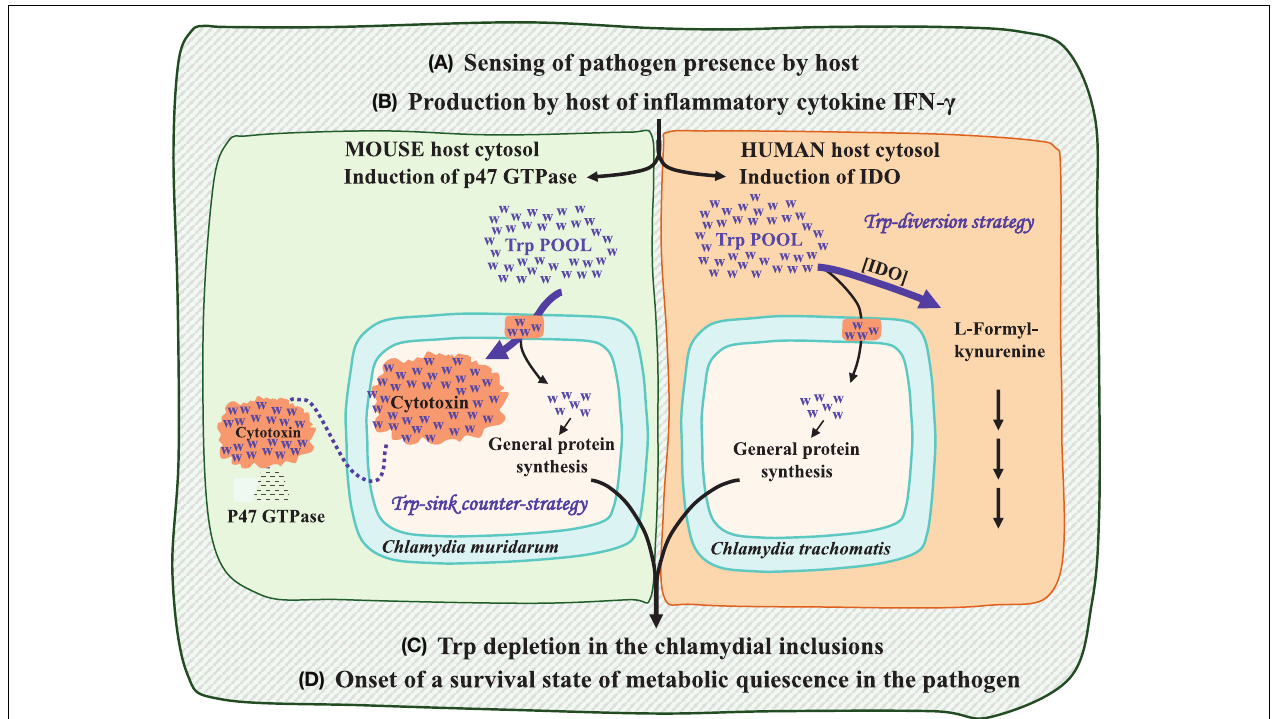
FIGURE 1 | Common and differential steps of the mammalian immune response: comparison of the mouse host (left side) with the human host (right side). Common steps are listed as (A–D) . Progression from step (B) to step (C) is mediated by different mechanisms. The human host deploys a strategy of Trp depletion via the action of an IFN- γ induced indoleamine dioxygenase (IDO). In the mouse host p47 GTPase production is the